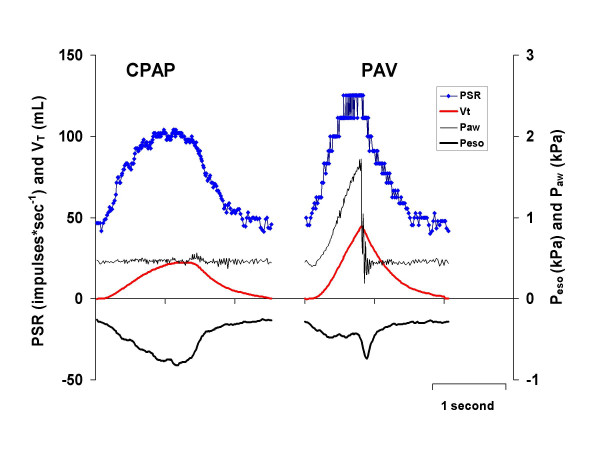
Recordings of Paw, VT, Peso, and PSR fimp during CPAP and PAV after lung lavage. Note the shorter time to peak PSR fimp and the higher peak PSR fimp during PAV than during CPAP, giving a shorter inspiratory time.